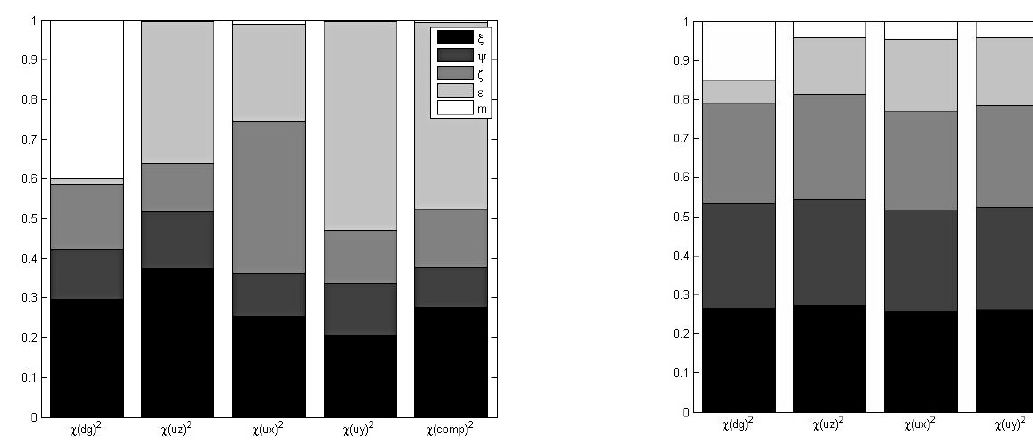
Fig. 6. Normalized E-FAST first order indices for the five defined output parameters (one run consisting of 28645 samples).